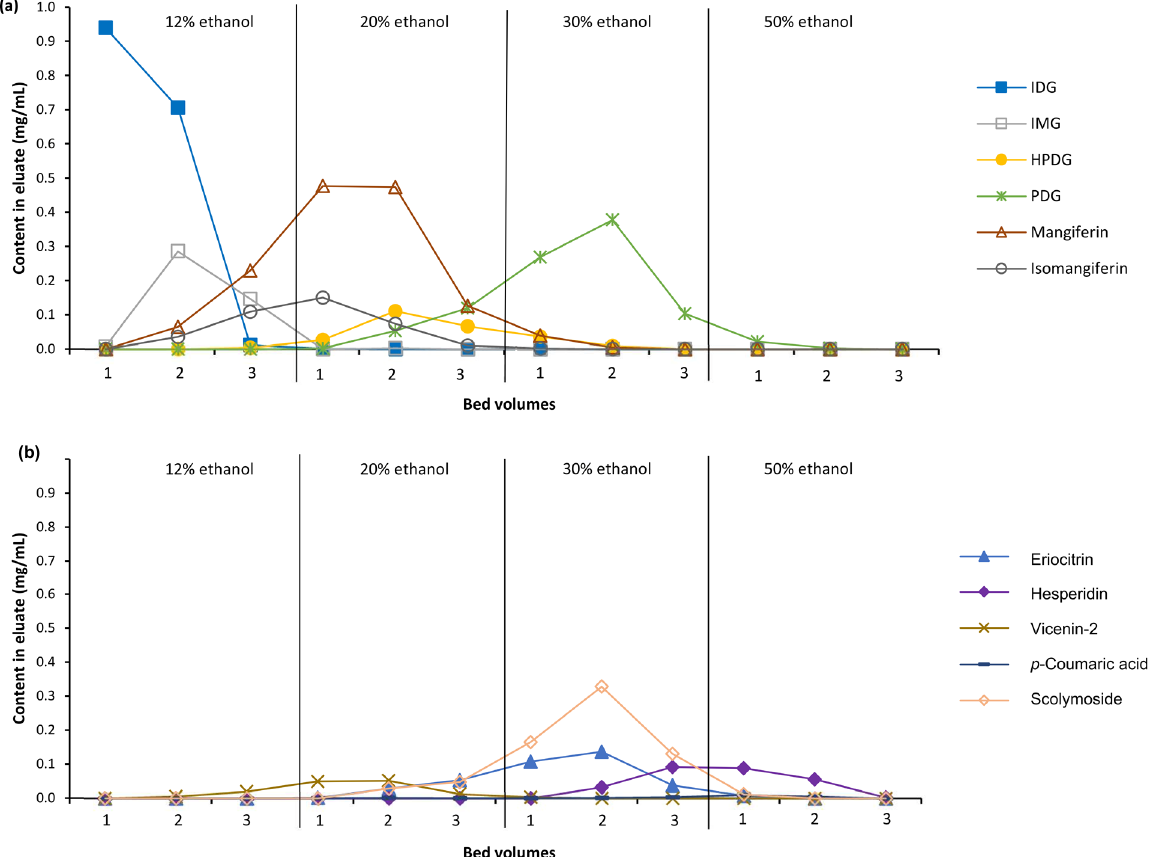
Figure 3. Dynamic desorption curves of Cyclopia subternata benzophenones, dihydrochalcones and xanthones ( a ) and flavanones, flavones and a phenolic acid ( b ) using different concentrations of ethanol solutions in the small-scale column. Abbreviations: IDG, 3- β - D -glucopyranosyl-4- O - β - D - glucopyranosyliriflophenone; IMG, 3- β - D -glucopyranosyliriflophenone; HPDG, 3 ′ ,5 ′ -di- β - D -gluco- pyranosyl-3-hydroxyphloretin; PDG, 3 ′ ,5 ′ -di- β - D -glucopyranosylphloretin.